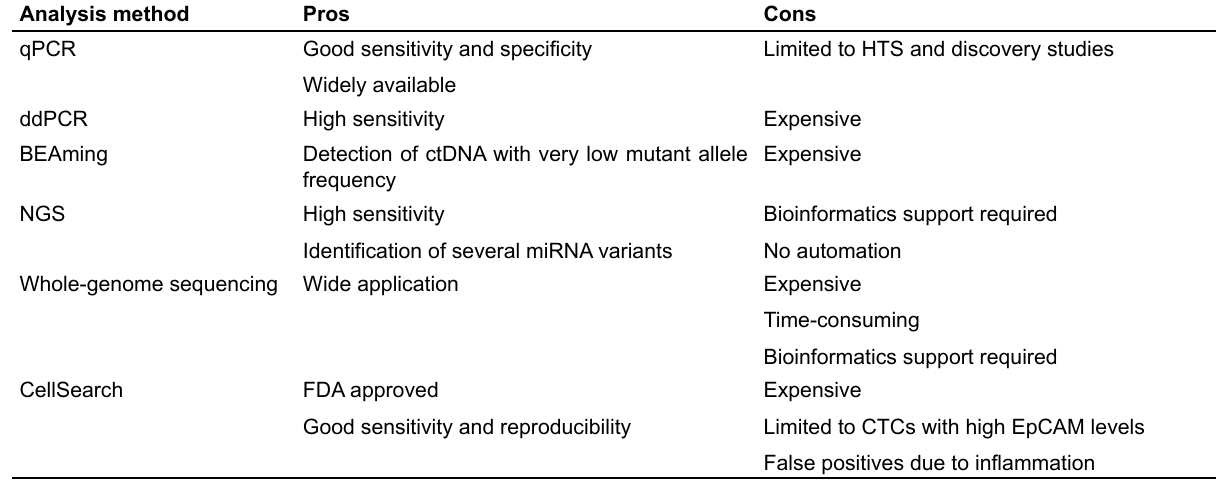
Table 1. Pros and cons of analysis methods used in liquid biopsies